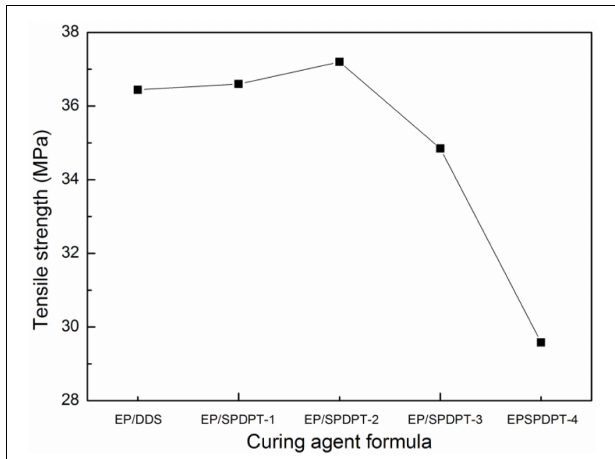
FIGURE 8 | Tensile properties of epoxy thermosets.